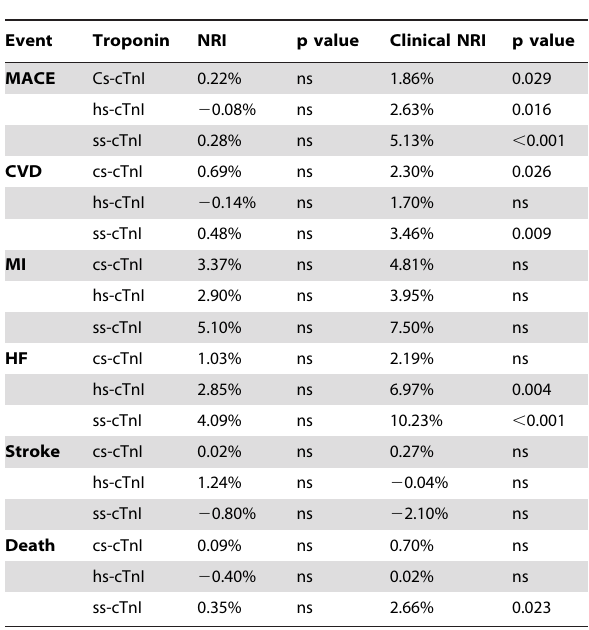
Table 4. Net Reclassification Improvement (NRI) and Clinical NRI for Various Endpoints for Baseline Troponin Assessed by Contemporary-Sensitivity, High-Sensitivity and Super- Sensitivity Assays in Addition to the Standard Framingham Risk